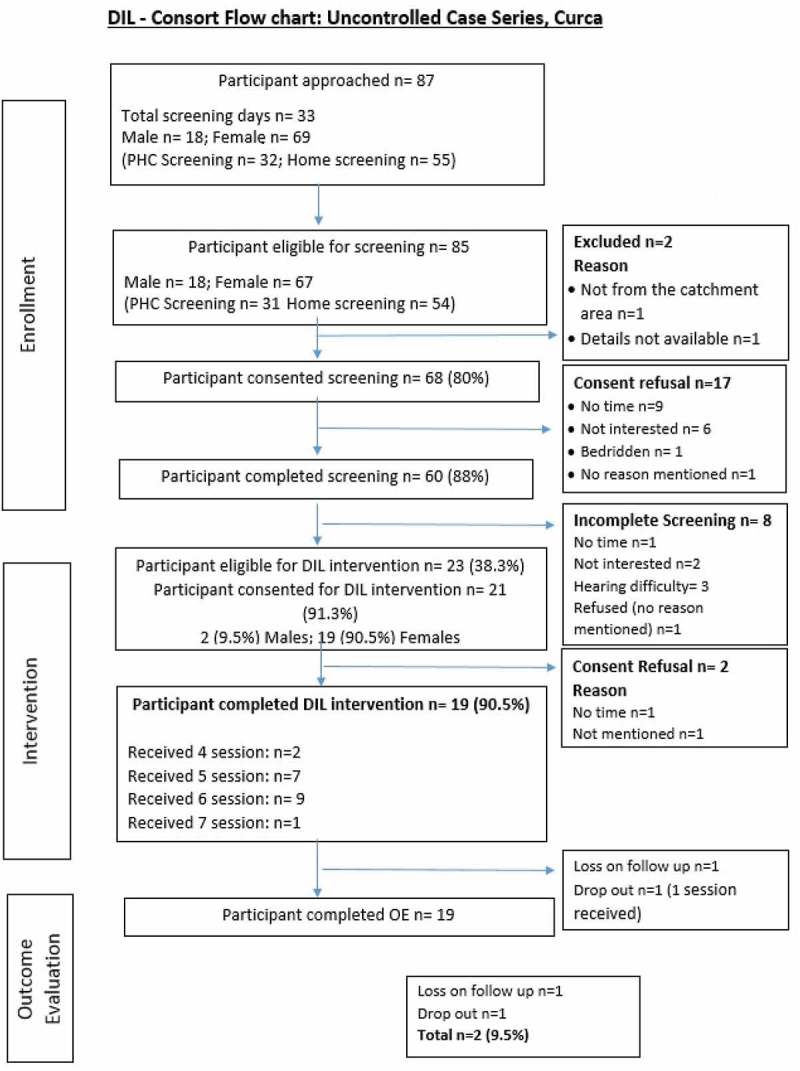
Consort – case series.